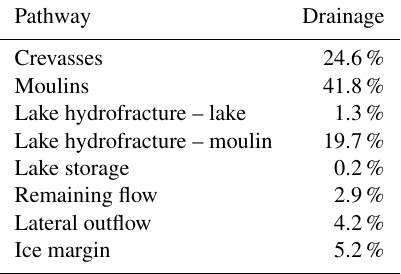
Table 3. Surface runoff partitioning into different meltwater path- ways for the 2009 melt season in the SRLF domain. Water flowing over the western boundary is categorized as “ice margin”, while wa- ter flow over the lateral boundaries is labelled as “lateral outflow”. “Remaining flow” refers to water still flowing over the ice sheet at the end of the model run. Water flowing into crevasses and moulins is in categories “crevasses” and “moulins”, respectively. “Lake stor- age” refers to water in lakes at the end of the simulation. “Lake hy- drofracture lake” refers to the water in lakes that is drained by hy- drofracture events themselves. “Lake hydrofracture moulin” refers to water drainage into the subsequent surface-to-bed connections from hydrofracture